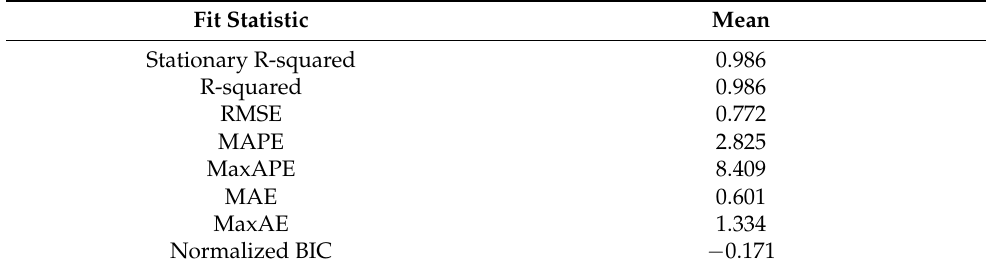
Table 1. Model fit for ARIMA forecast of share of total electricity consumed from renewable sources. Fit Statistic Mean Stationary R-squared 0.986 R-squared